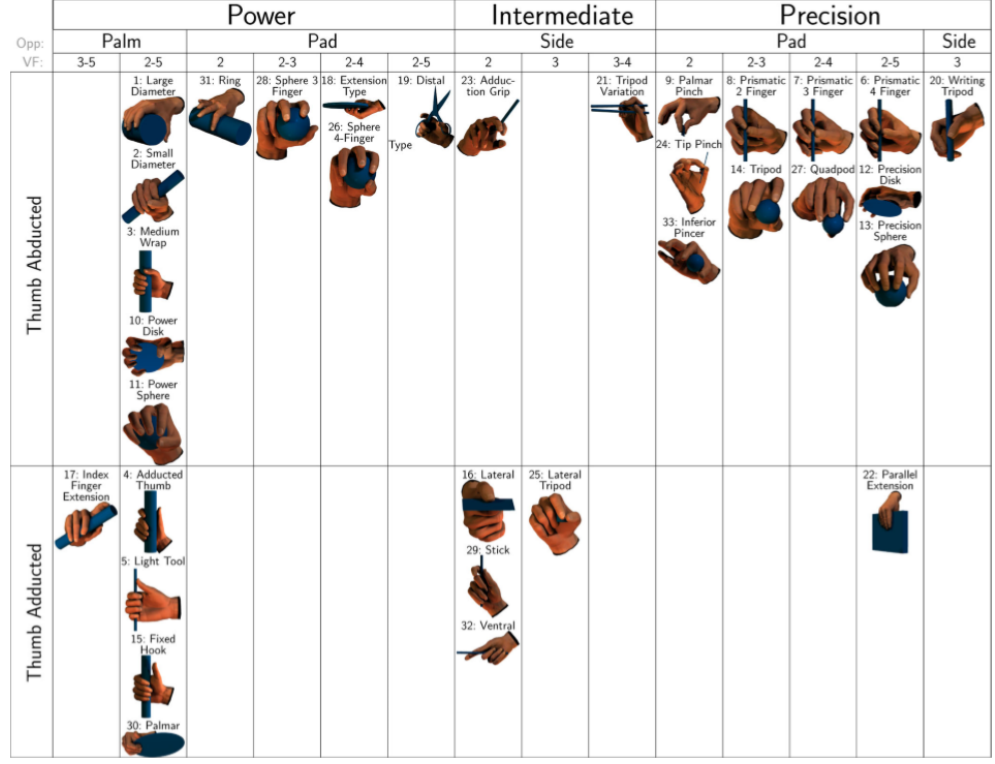
Figure 2. Feix grasp taxonomy. Reproduced with permission from [63], IEEE,